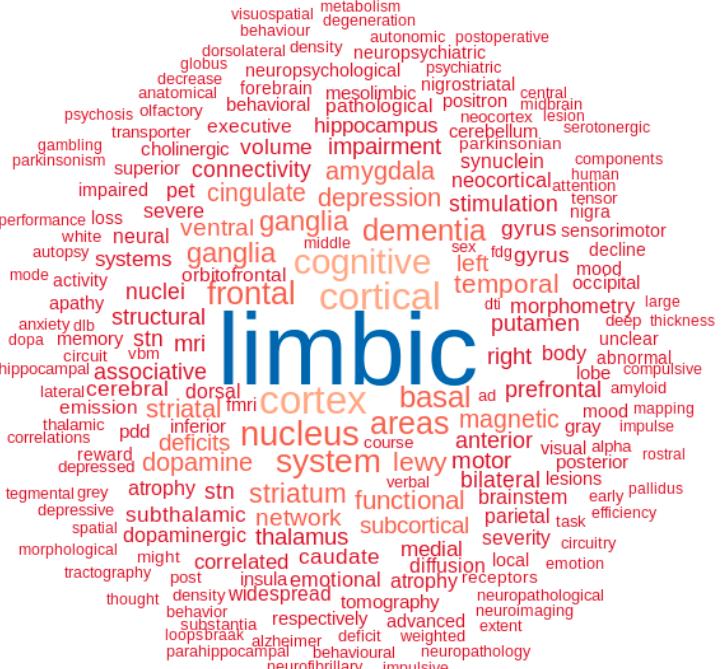
Figure 2. Representation of selected limbic regions affected by PD pathology and their associated clinical symptoms. Created with Biorender.com.